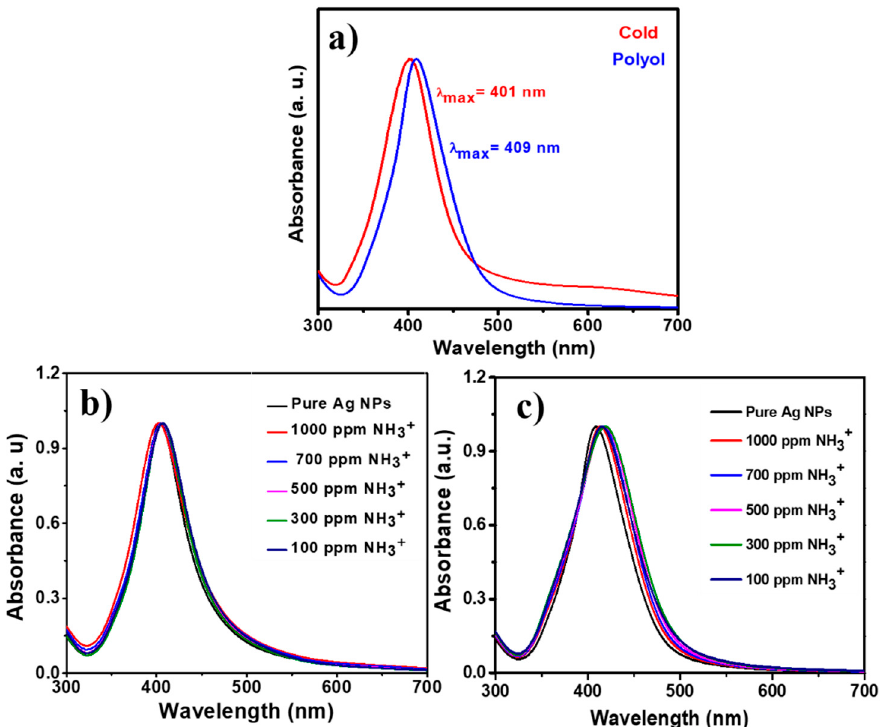
Figure 3. ( a ) UV-visible absorption spectra for PVP capped Ag-NPs synthesized, UV-visible absorp- tion spectra of PVP capped Ag-NPs synthesized by using ( b ) cold and ( c ) polyol synthesis methods with varying concentrations of ammonium solution.